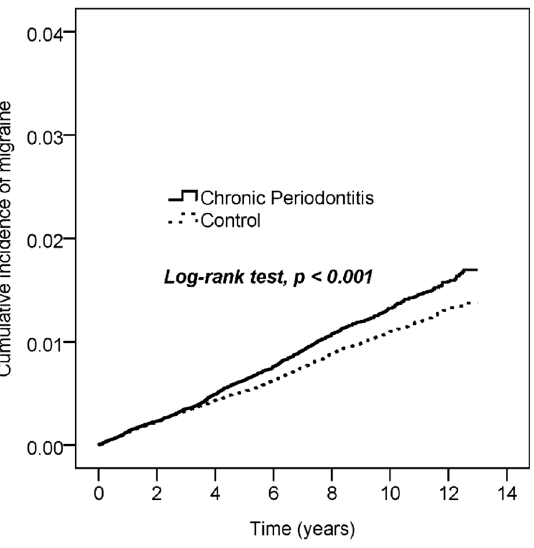
Figure 2. The Kaplan–Meier plot for the cumulative incidence of migraine with chronic periodontitis and control subjects in this cohort study.